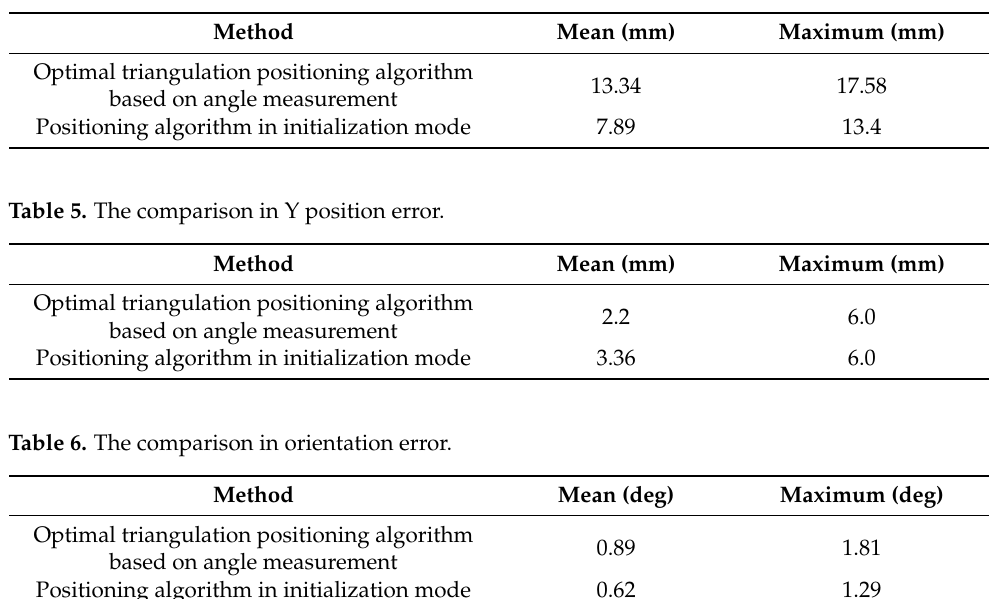
Table 4. The comparison in X position error.